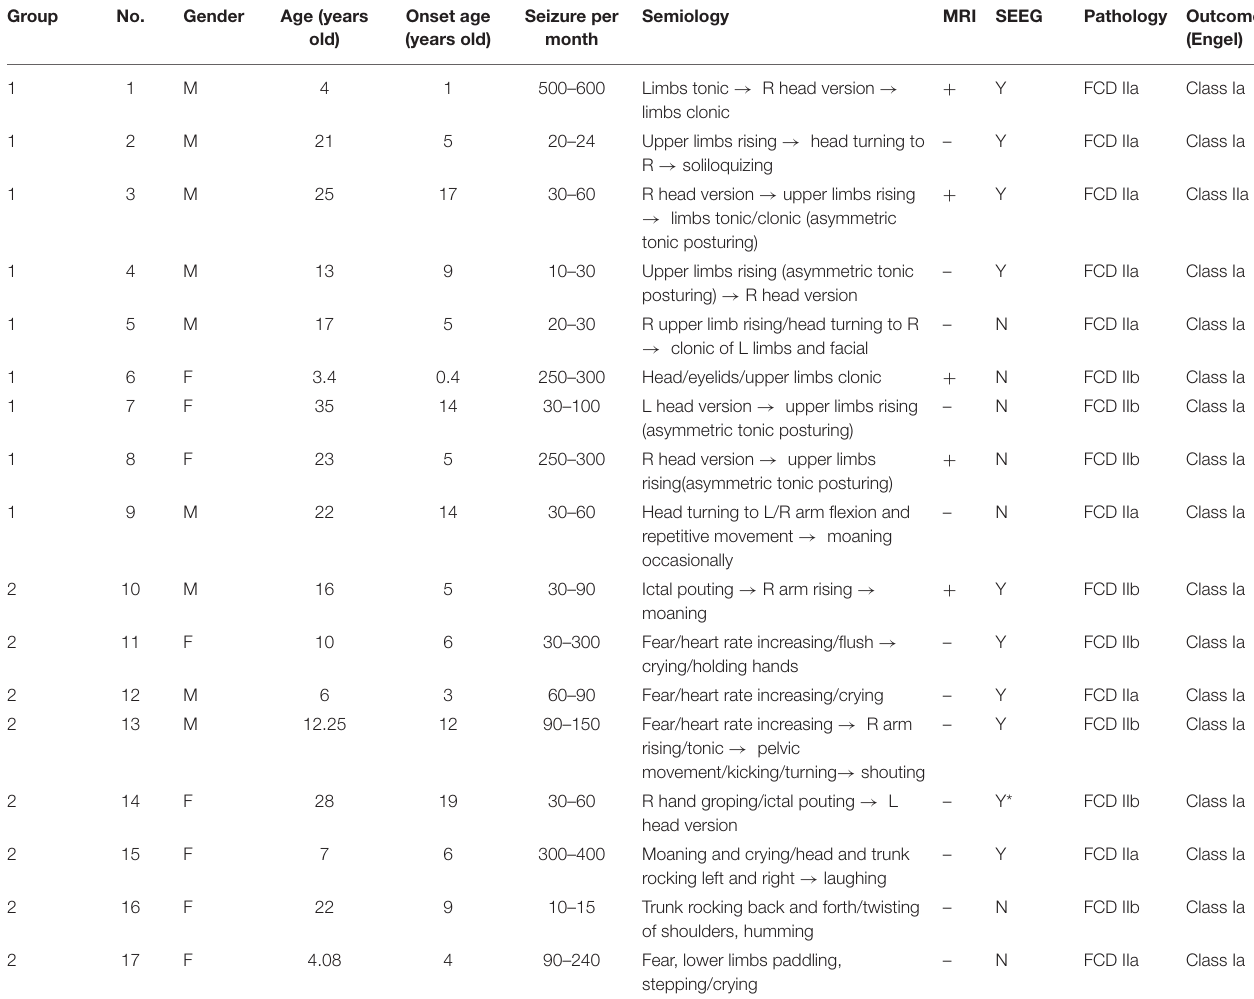
TABLE 1 | Demographic and clinical data of 17 SFS epilepsy patients.